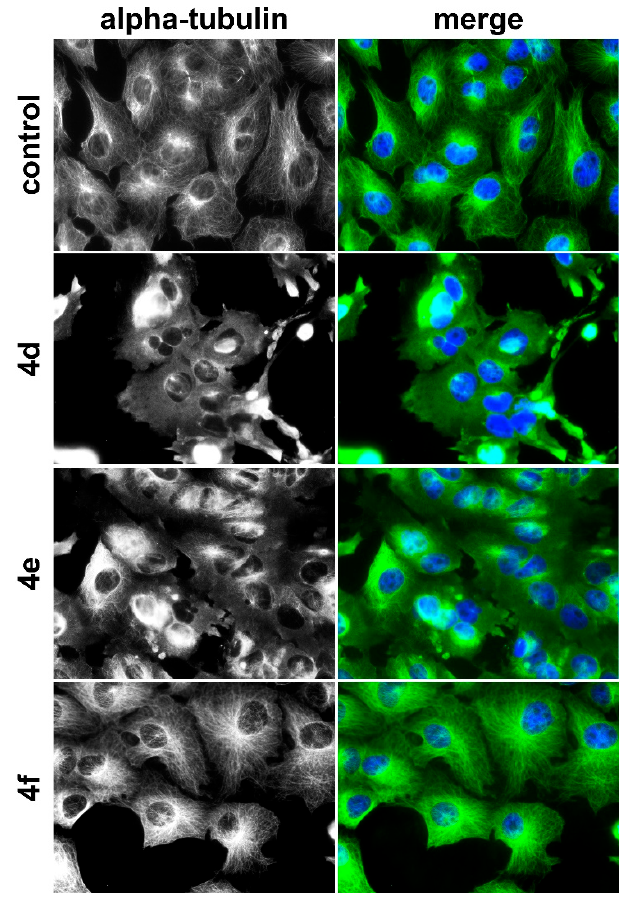
Figure 3. Effect of compounds 4d (0.5 µM), 4e (1.5 µM), 4f (4 µM), and vehicle (DMSO) on the organization of microtubule cytoskeleton in 518A2 melanoma cells after 24 h incubation. Nuclei were counterstained with DAPI (merge, blue); microtubule (green). Pictures are representative of two independent experiments (400× magnification).